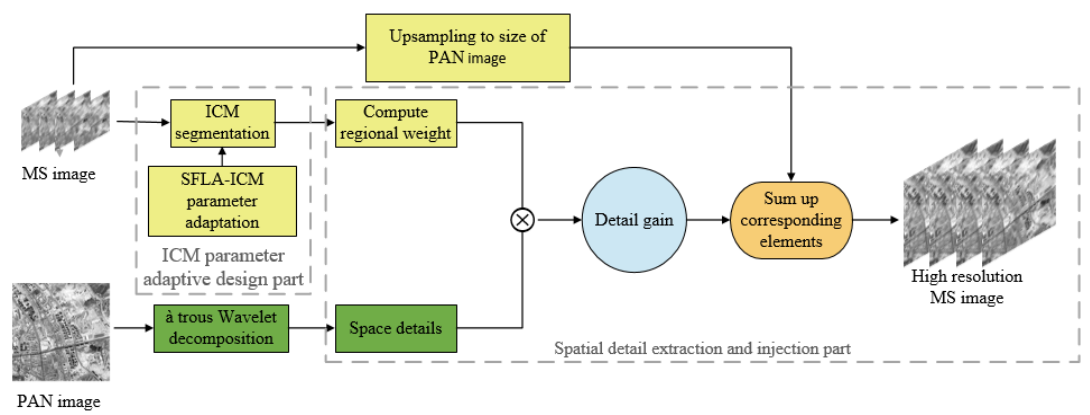
Figure 2. Schematic diagram of algorithm